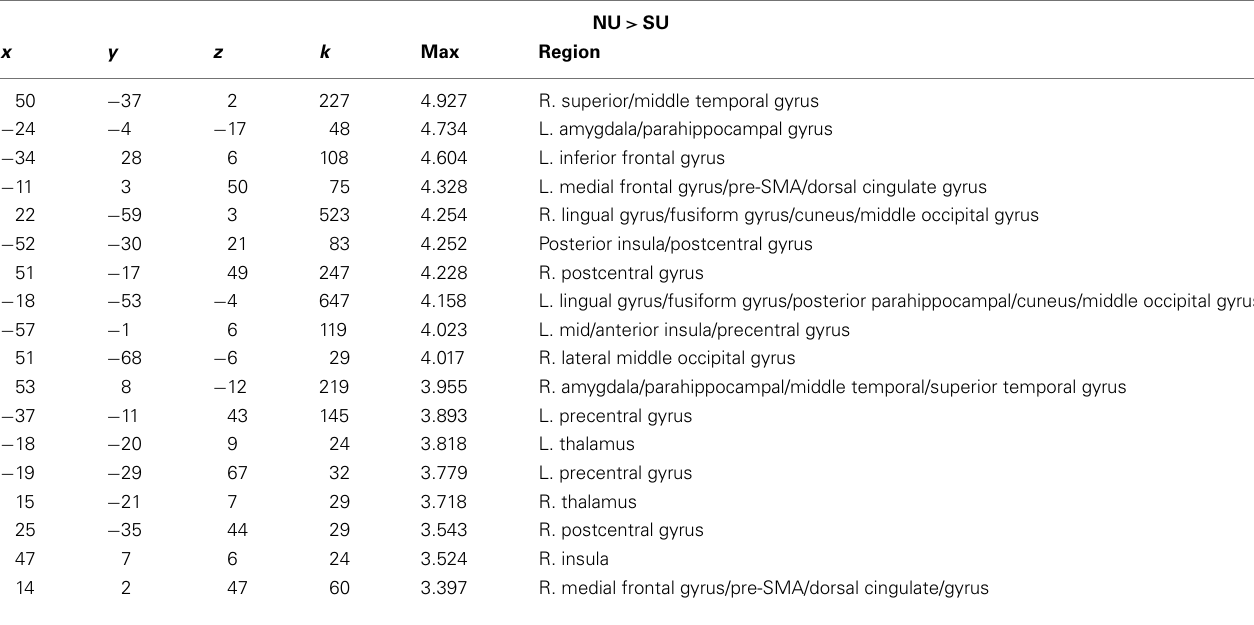
Table 5 | x , y , z coordinates, max activation, and cluster size for the contrast of non-using > substance-using mothers for low-distress infant